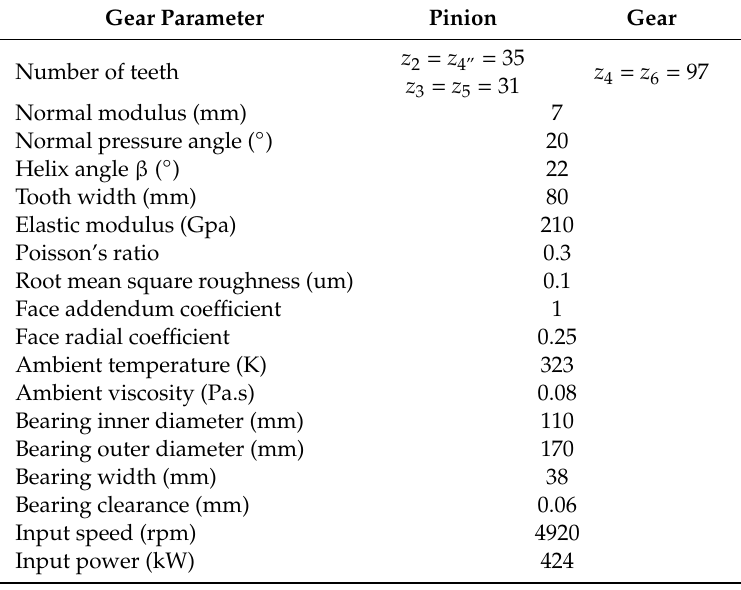
Table 3. Main parameters of high-speed heavy-duty herringbone gear transmission